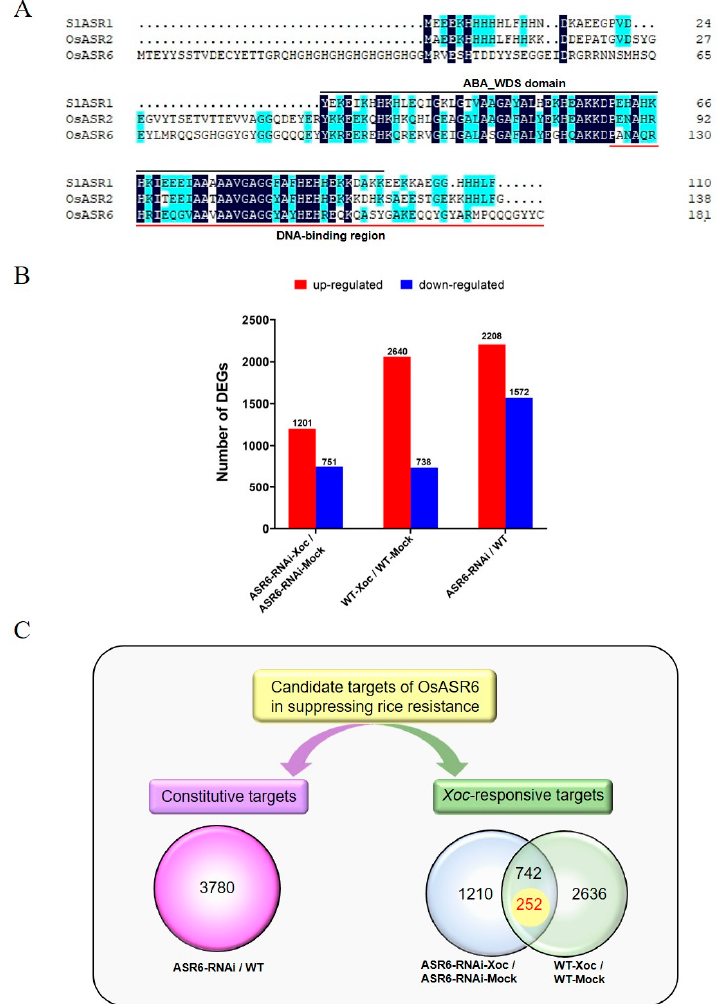
Figure 4. Identification of potential OsASR6 targets through transcriptome analyses. ( A ) Amino acid sequence alignment of OsASR6 with SlASR1 and OsASR2. The conserved ABA_WDS domain is overlined in black while the potential DNA-binding region is underlined in red. The identical and homologous amino acids are highlighted in blue and turquoise respectively. ( B ) Types of differentially expressed genes (DEGs). ASR6-RNAi/WT, comparison between un-inoculated OsASR6-RNAi and WT rice plants; ASR6-RNAi-Xoc/ASR6-RNAi-mock: comparison between Xoc -inoculated and mock-inoculated OsASR6-RNAi rice plants; WT-Xoc/WT-mock, comparison between Xoc -inoculated and mock-inoculated WT rice plants. ( C ) The strategies to identify constitutive and Xoc -responsive targets of OsASR6 function in suppressing rice resistance. Venn diagram showing the overlap between the Xoc -responsive genes in the WT and OsASR6-RNAi plants. The total number of overlapped DEGs is 742, among which 252 displayed reverse trend of Xoc -responsive expression in the WT and OsASR6-RNAi